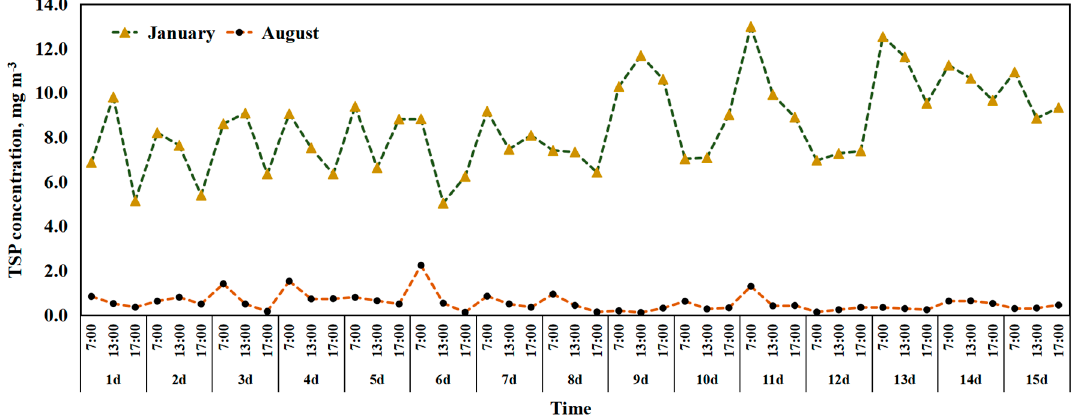
Figure 5. Total suspended particles (TSP) concentration variations among different sampling times during winter and summer.